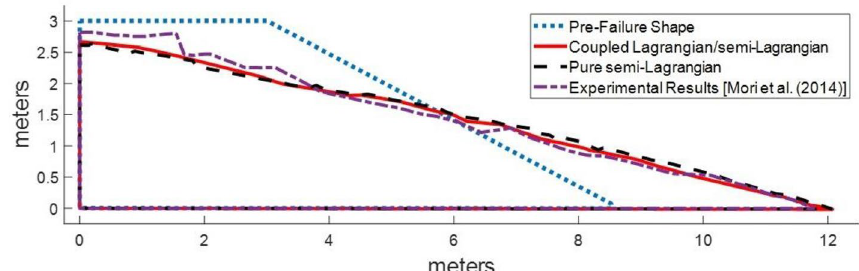
Fig. 23 Post‑failure final shapes; the blue dotted line represents the pre‑failure shape; the solid red line represents the coupled L–SL post‑failure shape; the dashed black line represents the pure SL post‑failure shape; the purple dot‑dashed line represents the experimental results from [90]